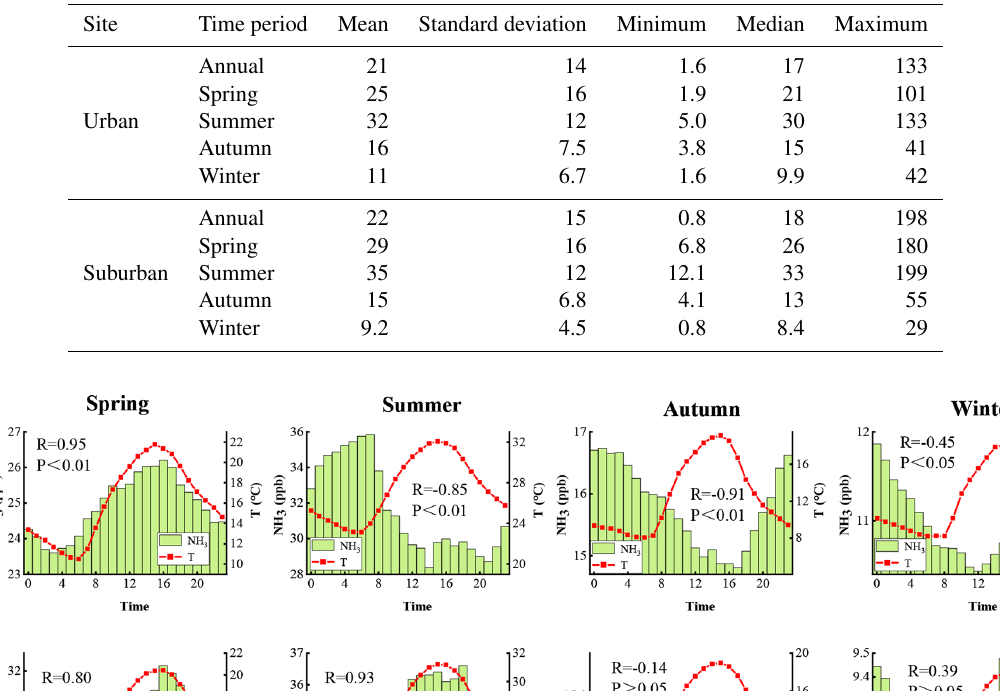
Table 2. NH 3 mixing ratios (ppb) measured at the urban and suburban sites in Beijing.